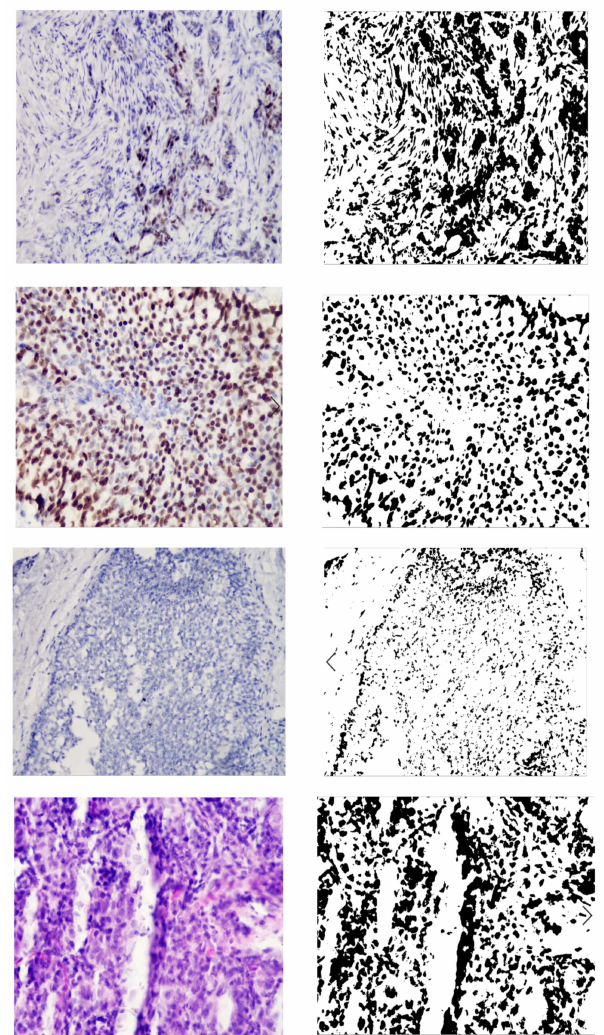
Figure 3. Original and generated images.